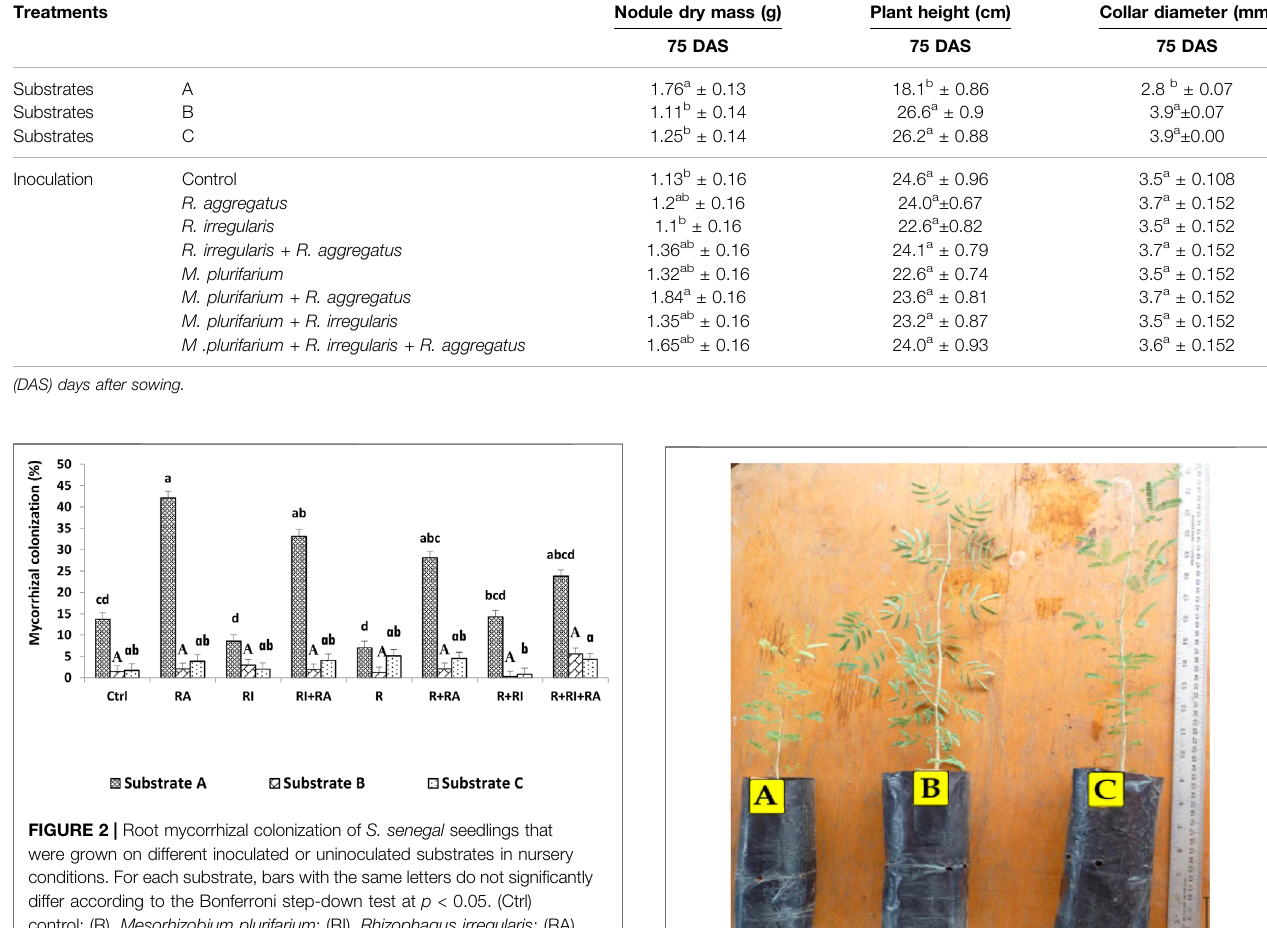
TABLE2| Nodulation(noduledrymass)andGrowth(height)of S.senegal seedlingsthatweregrownondifferentinoculatedoruninoculatedsubstratesinnurseryconditions (75 DAS). Foreach factor, means of variables followed by thesameletter in the same column do notsigni fi cantlydiffer according tothe Bonferroni step-down test at p < 0.05. Means ± standard errors are shown (n = 8).